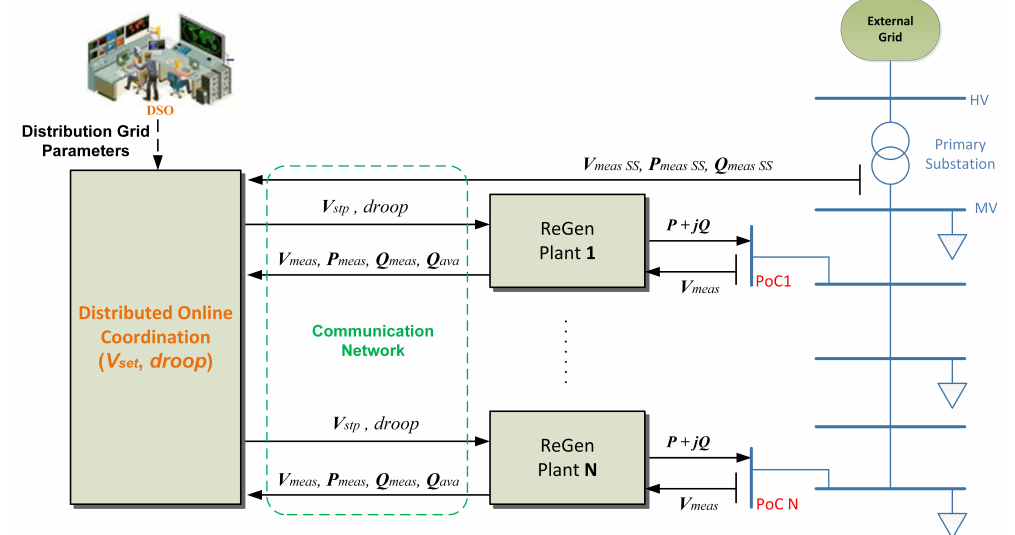
Figure 3. Control architecture for distributed online voltage